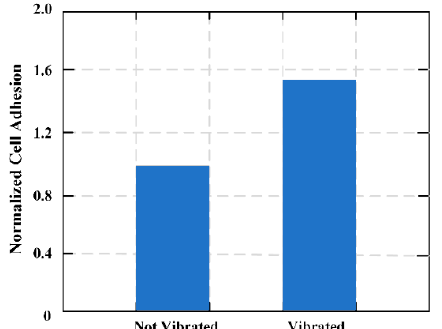
Figure 14. Effects of vibrations (<10 nm) on fibroblast adhesion to plasma-treated Paryene-C coated magnetoelastic sensor (MES) films.